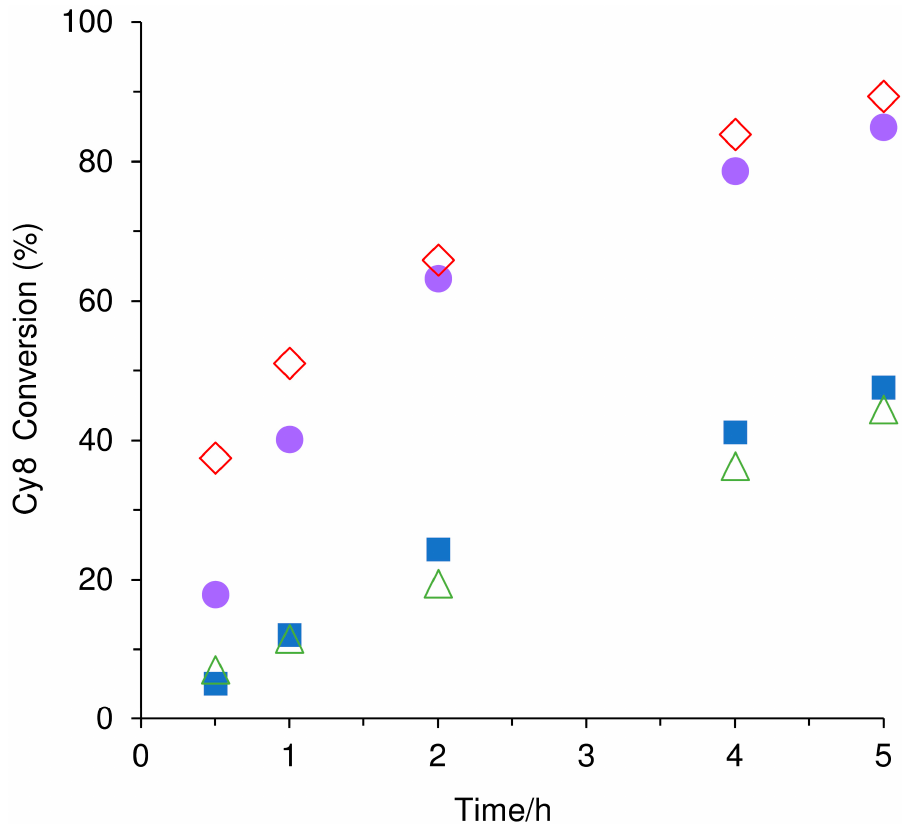
Figure 8. Kinetic profiles of the reaction of cis ‐ cyclooctene (Cy8) with tert ‐ butyl hydroperoxide (TBHP), in the presence of 2 , using α , α , α‐ trifluorotoluene (TFT) ( ◇ ), ethanol (EtOH) ( ● ), ethyl acetate (EA) ( ■ ), or isobutyl acetate (IBA) ( △ ) as solvent, at 70 °C.